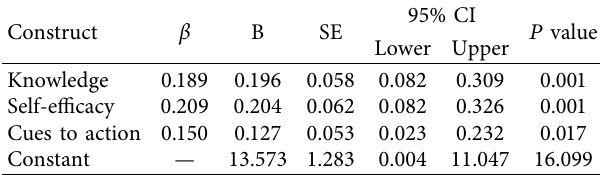
Table 5: Predicting brucellosis prevention behavior